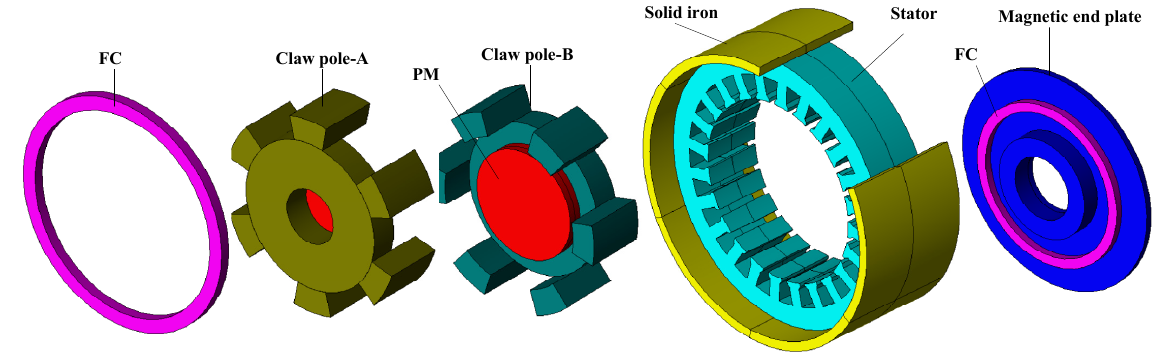
Figure 6. Configuration of the mixed ‐ excited HE machine with claw pole rotor [36].